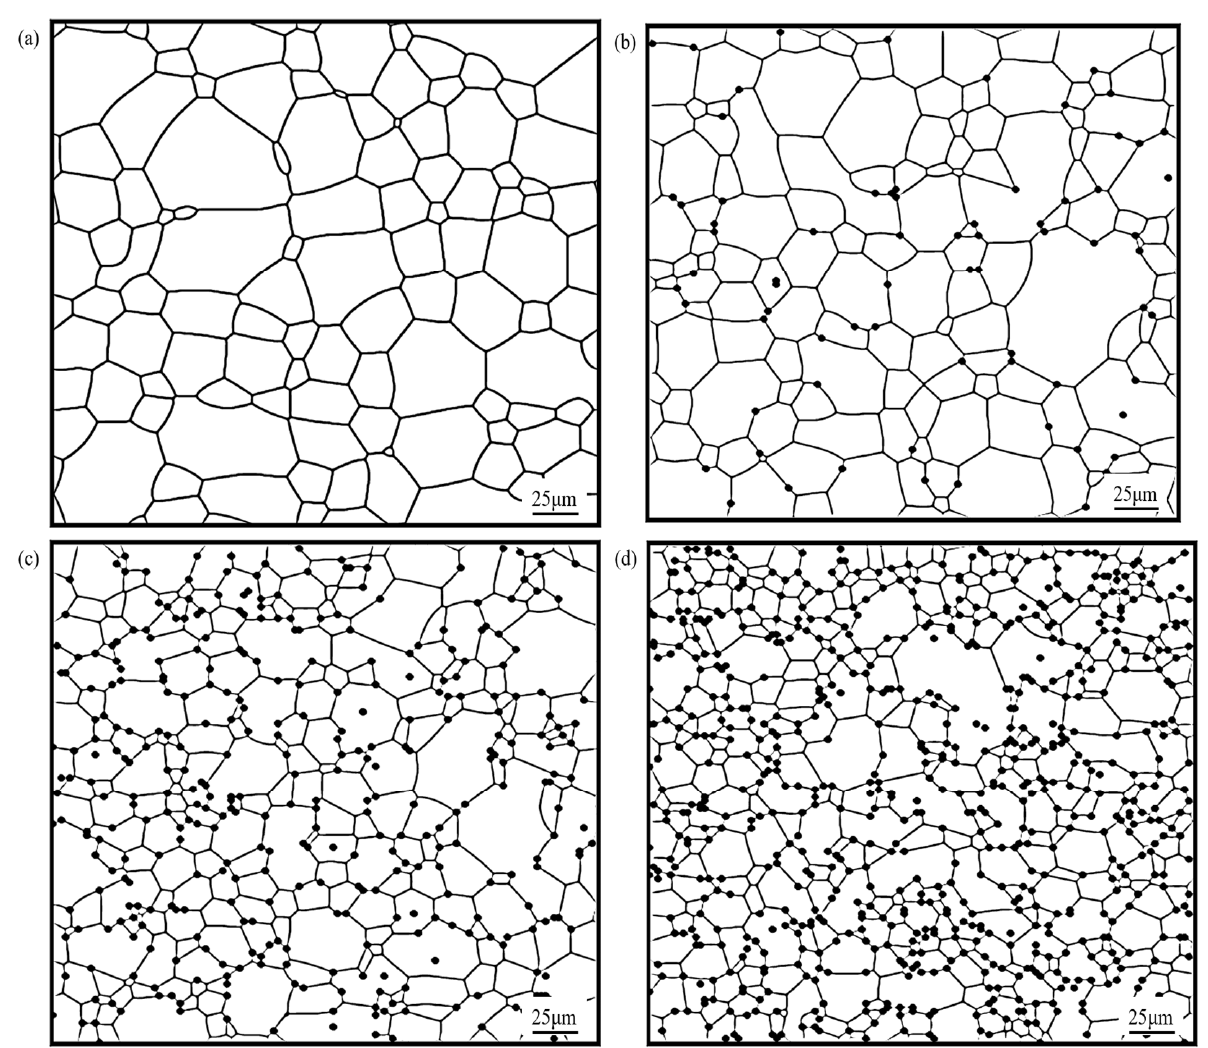
Figure 4. Simulation results for different particle volume fractions and simulation time of t = 100 min for the second-phase particle size r = 1 µ m: ( a ) f = 0%; ( b ) r = 1 µ m, and f = 1%; ( c) r = 1 µ m, and f = 5%; ( d ) r = 1 µ m, and f = 10%